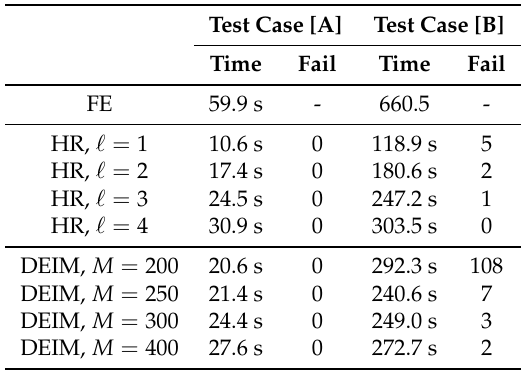
1,2,3,4 , DEIM for M 200,250,300,400 magic ∈ { } ∈ { } Test Case